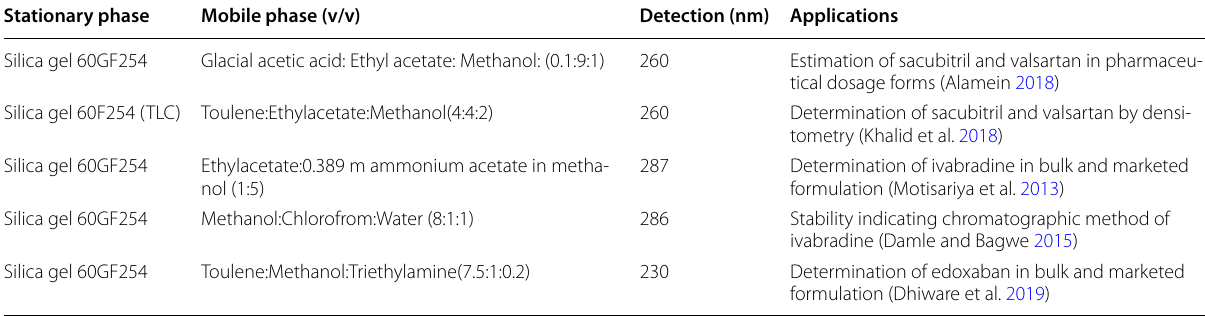
Table 4 TLC and HPTLC methods for analysis of FDA-approved treatments for several cardiovascular illnesses from 2015 to June